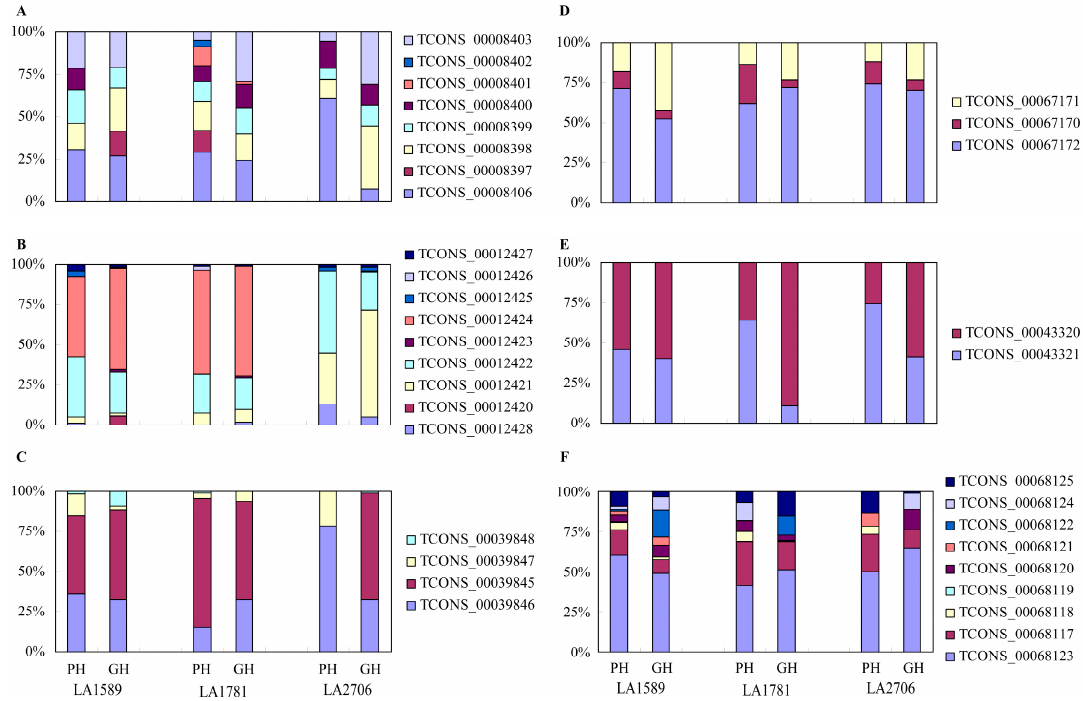
Figure 6. Isoform expression patterns of six representative differential splicing genes. ( A ) Isoform expression pattern of the differential splicing gene SR30 ( Solyc01g099810 ) . The transcript abundance for six of the nine SR30 isoforms showed variations in response to growth condition changes and most of them were more abundant in PH seedlings; ( B ) Isoform expression pattern of the differential splicing gene Solyc02g088720 , similar to Arabidopsis LIF2. Only two of its nine mRNA isoforms were predominantly expressed under a particular growth condition; ( C ) Isoform expression pattern of the differential splicing gene Solyc07g008750 , encoding a protein similar to Exosome-associated factor Rrp47/C1D family member . Under particular conditions, two isoforms contributed to the majority of transcript abundance; ( D ) Isoform expression pattern of the differential splicing gene PAT1 ( Solyc12g005340 ); ( E ) Isoform expression pattern of the differential splicing gene Lhcb2.1 ( Solyc07g047850 ); ( F ) Isoform expression pattern of the differential splicing gene Solyc12g021280 , similar to Arabidopsis STT7 HOMOLOG STN7 ( STN7 ).